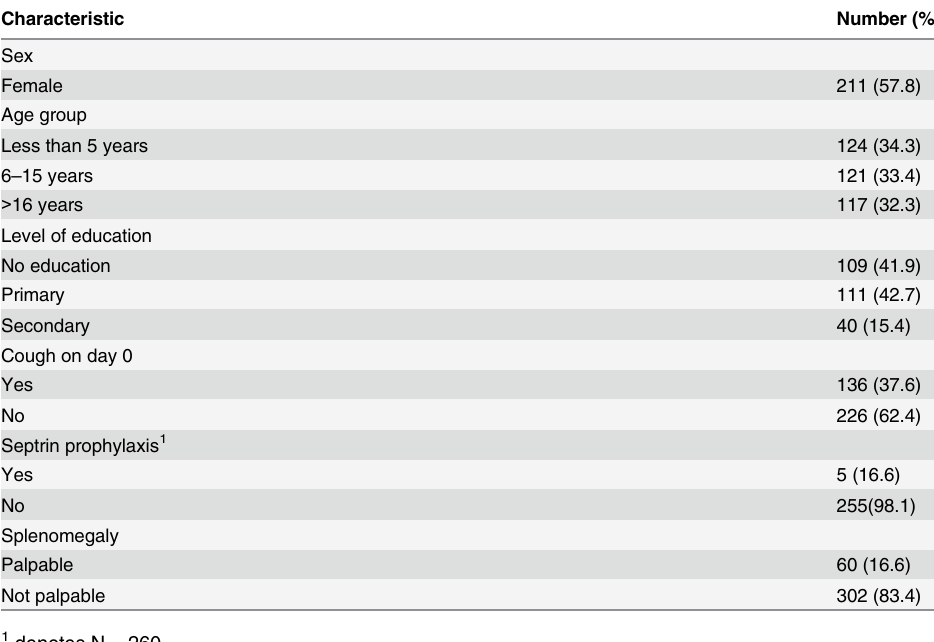
Table 1. Characteristics of the study population (N =